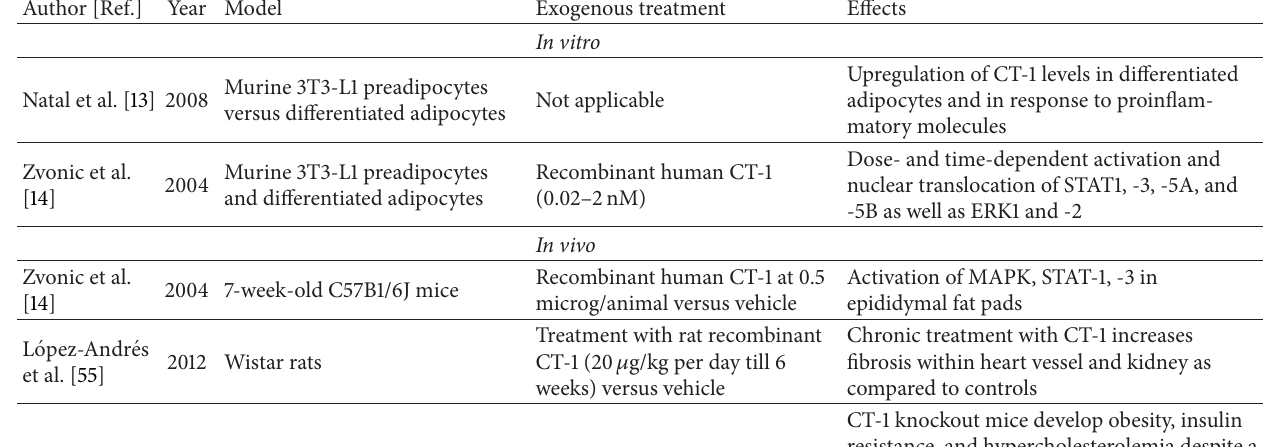
Table 1: Summary of the most relevant CT-1-mediated effects in vitro , in vivo , and in humans in adipose tissue and obesity. Author [Ref.] Year